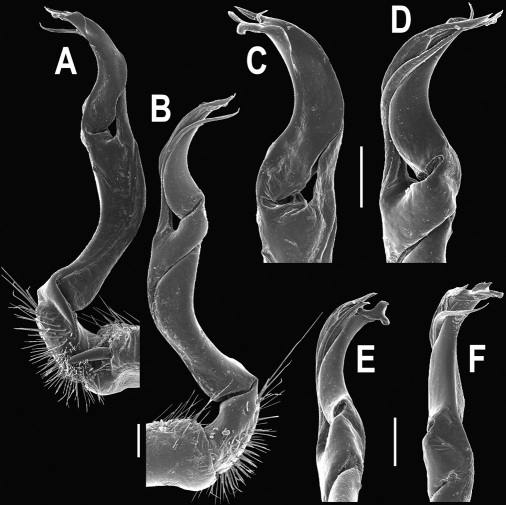
Orthomorpha holorogiformis Golovatch, 1998, ♂ from Samorakot. A, B right gonopod, mesal and lateral views, respectively C-F distal part of right gonopod, mesal, lateral, subcaudal and suboral views, respectively. Scale bar: 0.2 mm.